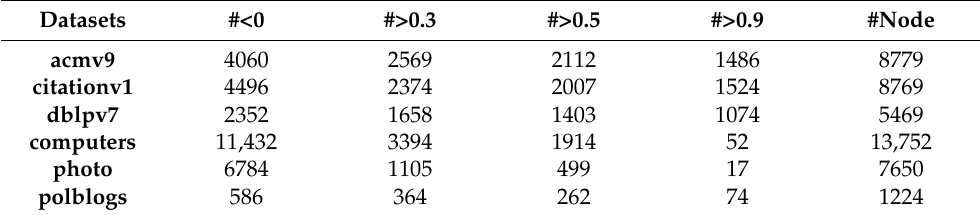
Table 8. The statistics of Pearson correlation coefficient between the number of motifs and the learned attention weights. “ #<0 ” represents the number of nodes with coefficient less that 0, and the same for others. “ #Node ” represents the total number of nodes of